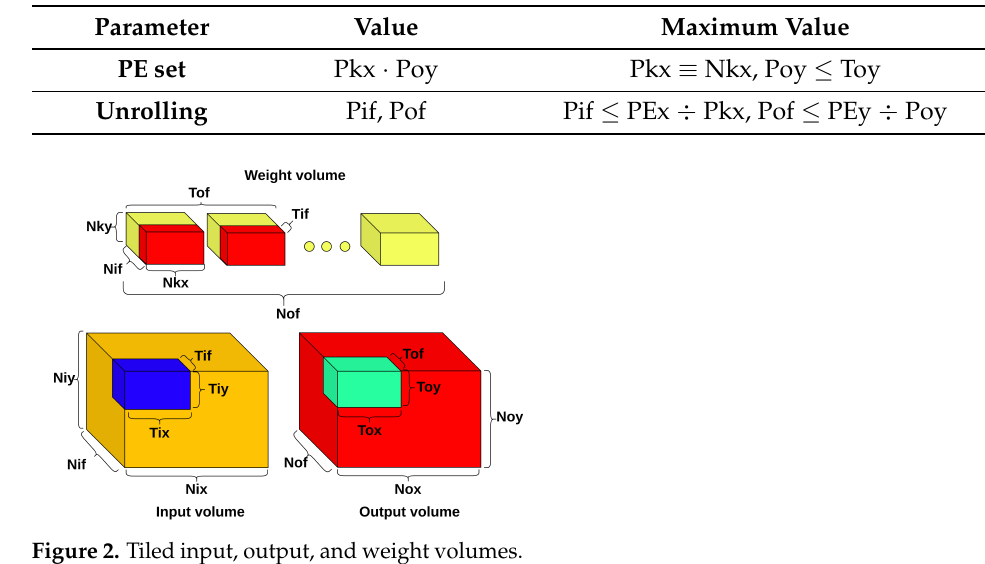
Table 2. Row-stationary mapping parameters.